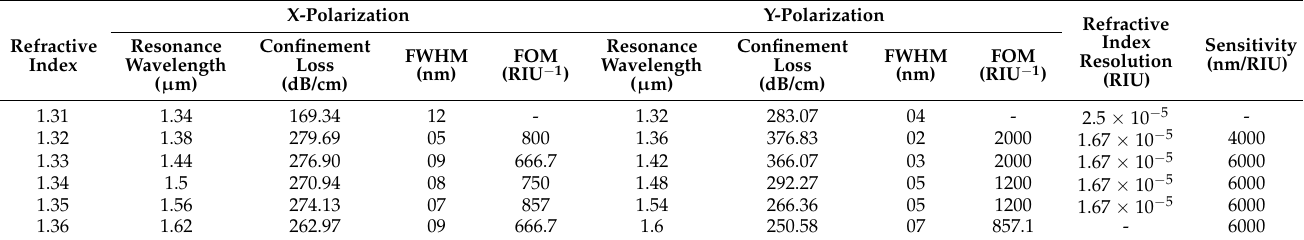
Table 2. Comparative study of the sensor’s performance and sensors in other recent published Table 1. Sensitivity analysis for different analyte RI values. work.